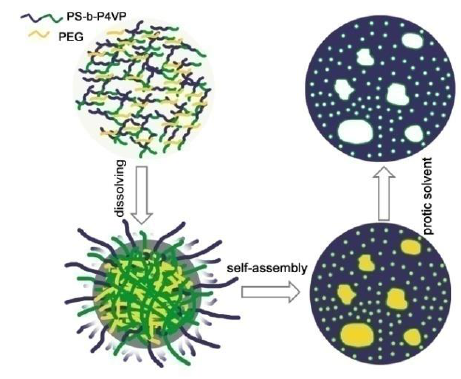
Figure 1. Schematic illustration for the fabrication of the hierarchically porous PS- b -P4VP